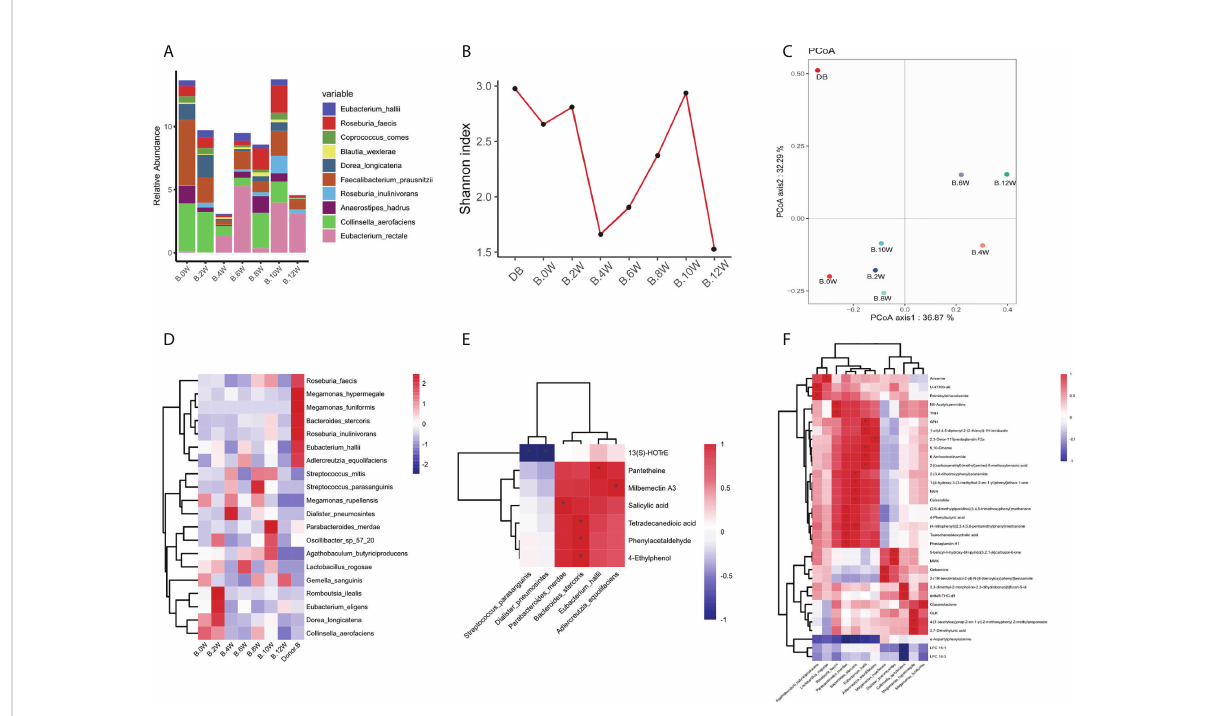
FIGURE 4 Characteristics of gastrointestinal microbiota in patient case 2. (A) . Composition of the top 10 species at the species level. (B) . The diversity (Shannon index) of gastrointestinal microbiota. (C) . Principal coordinate analysis (PCoA) was used to investigate the similarity of microbial communities at different time points. (D) . Strains with the same change trend before and after treatment with three treatments. (E) . Correlation between strains with the same change trend and metabolites in pos mode. (F) . Correlation between strains with the same change trend and metabolites in neg mode. *p < 0.05.